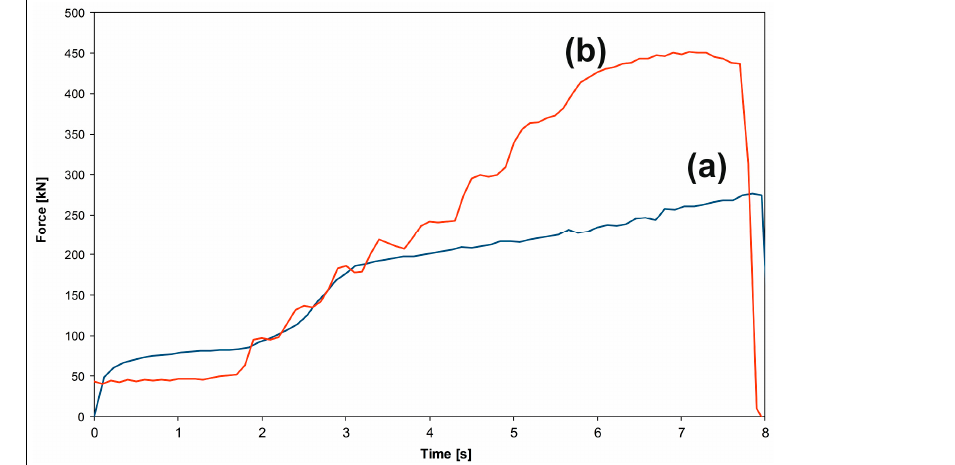
Materials 2023 , 16 , x FOR PEER REVIEW Figure 4. Force variation in the HSHPT process. ( a ) FEA, ( b ) experimental for disk-shaped work- Figure 4. Force variation in the HSHPT process. (a) FEA, (b) experimental for disk-shaped workpiece. piece.